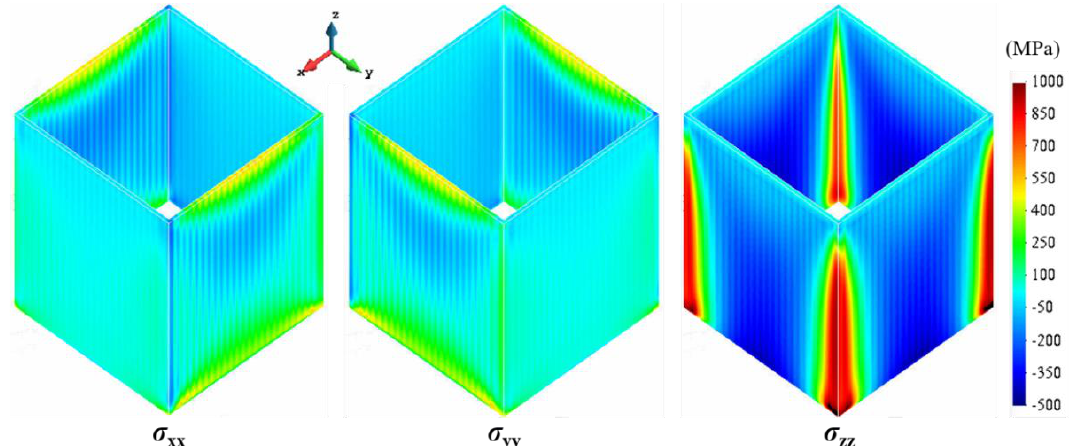
Figure 15. Comparison between the ( a ) experimental and ( b ) simulated displacement distributions of the hollow square part.